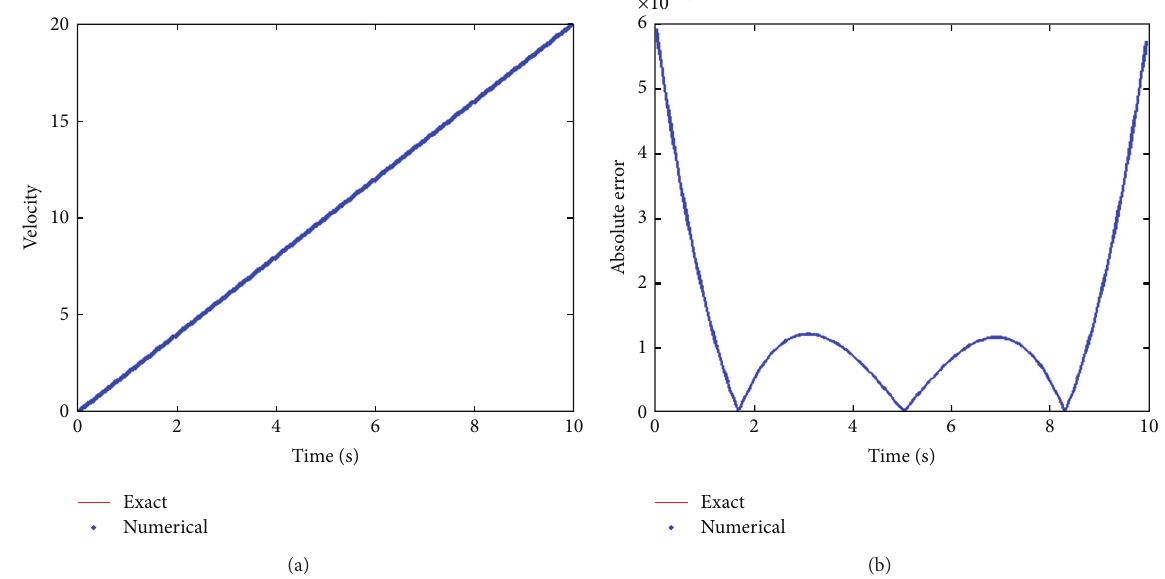
Figure 2: For Example 1, (a) comparing the exact solution and numerical one for velocity and (b) displaying the estimated error of velocity.